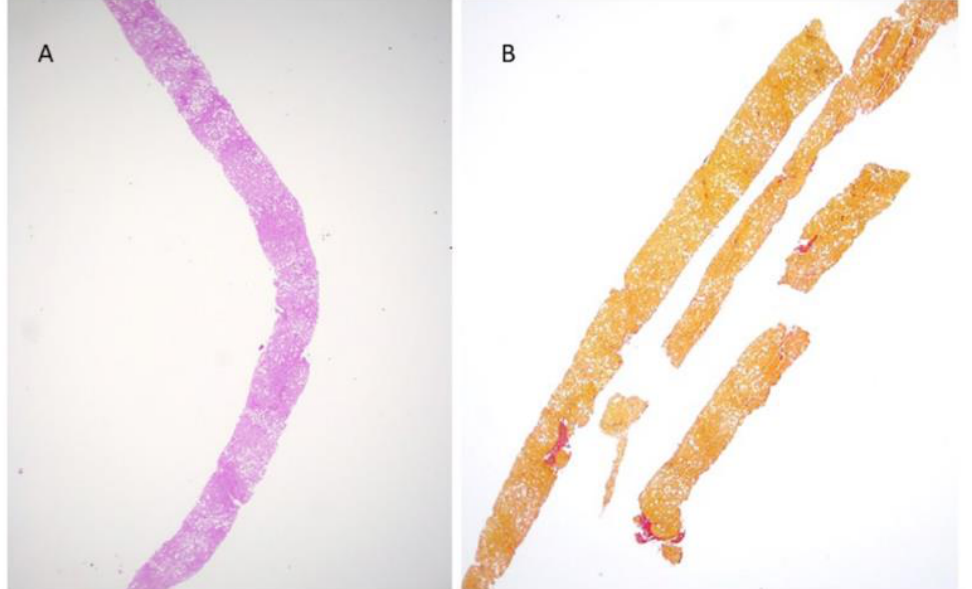
Figure 4. ( A ) Moderate steatosis with minimal lobular inflammation at presentation (H&E; original magnification 2.5 × ); ( B ) same patient 15 years later did not show any fibrosis progression (Van Gieson’s stain; original magnification 2.5×). Among patients who had fibrosis progression, 16 (76.1%) carried PNPLA3 GG, but the rate was not statistically higher when compared to the 93.3% of non-progressors ( p = 0.27).